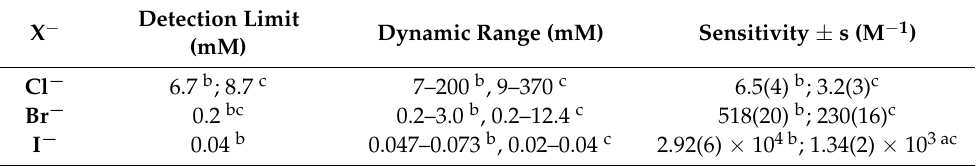
Table 2. The statistical parameters for the halide sensor based on the Tl(III)-PAR system. For the sake of clarity, the standard deviations of parameters are given in parentheses.